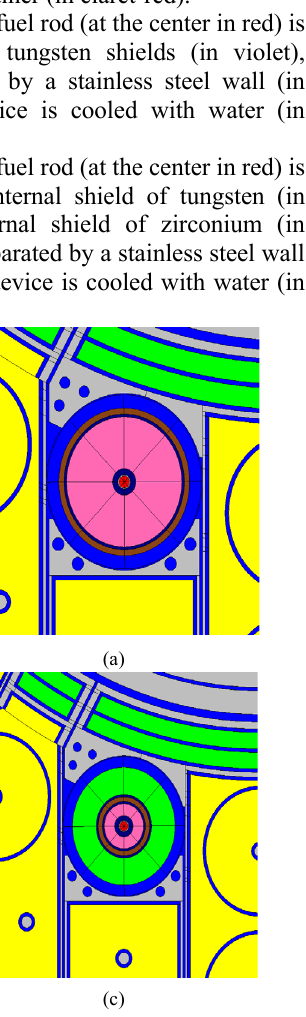
Fig. 4. Device configurations. (a): configuration 1. (b): configuration 2. (c): configuration 3. (d): configuration